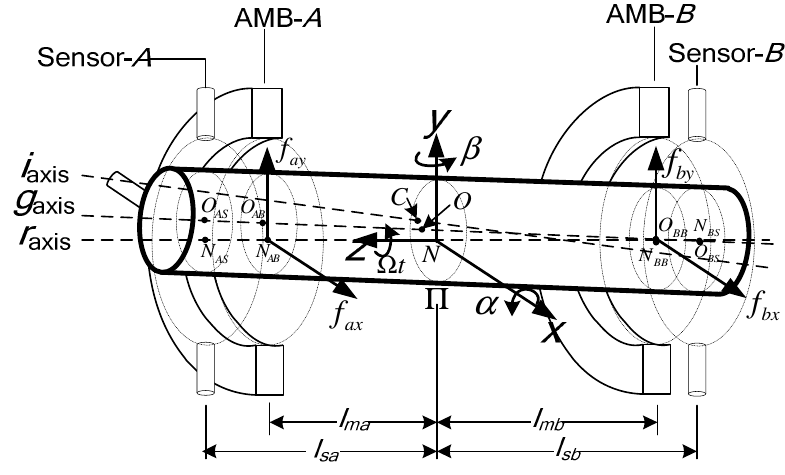
Figure 2. Schematic of an unbalanced rotor supported by two radial